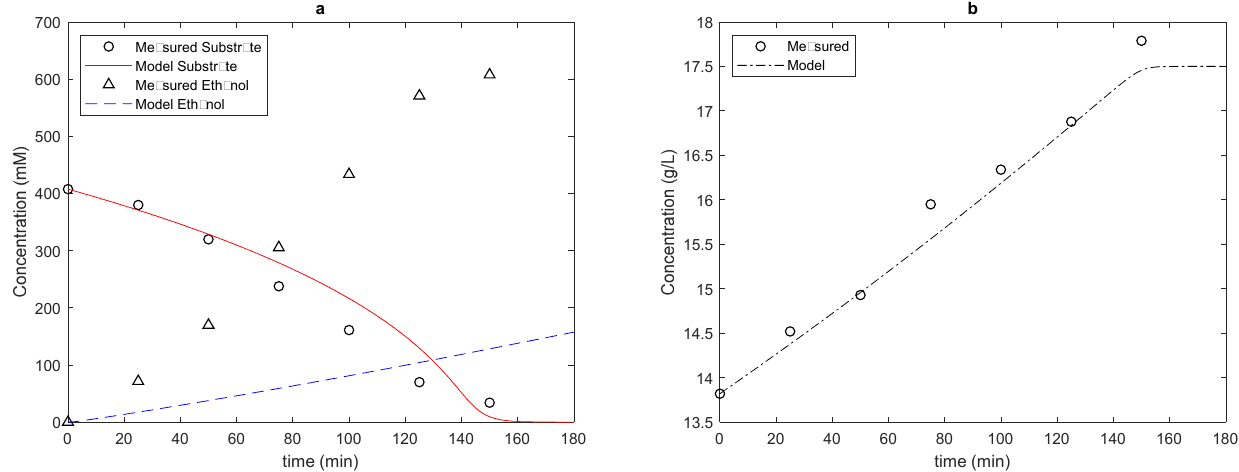
Figure 3. ( a ) SR model result with an initial concentration of 75 g/L, and ( b ) adjustment of cell concentration. Source: prepared by the author.